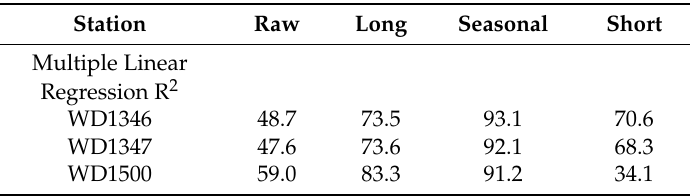
Table 1. Coefficient of determination (R 2 ) of the raw and decomposed data for the explanation of the water discharge time series using the MLR